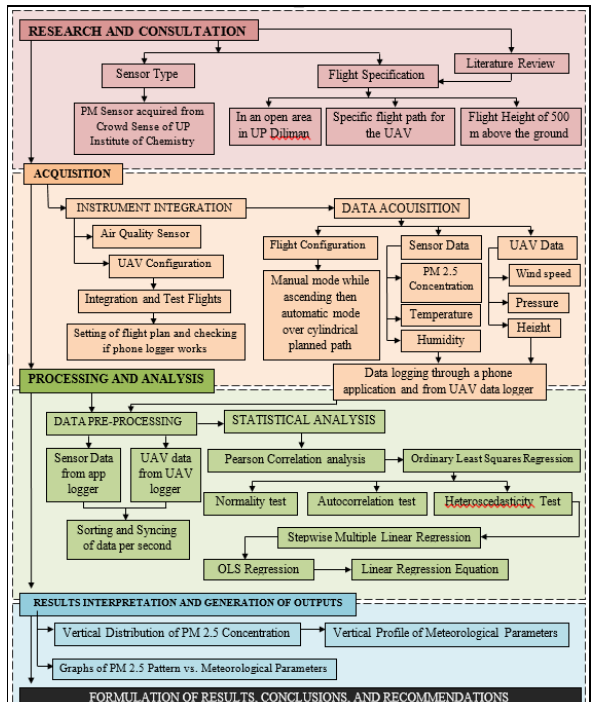
Figure 10. Research framework and detailed methodology For the recording of air quality sensor data, a phone was placed and taped under the top fuselage hatch and was connected via Bluetooth to the sensor. The flight plan was plotted using ArduPilot and test flights were held to check if the phone logger application works.